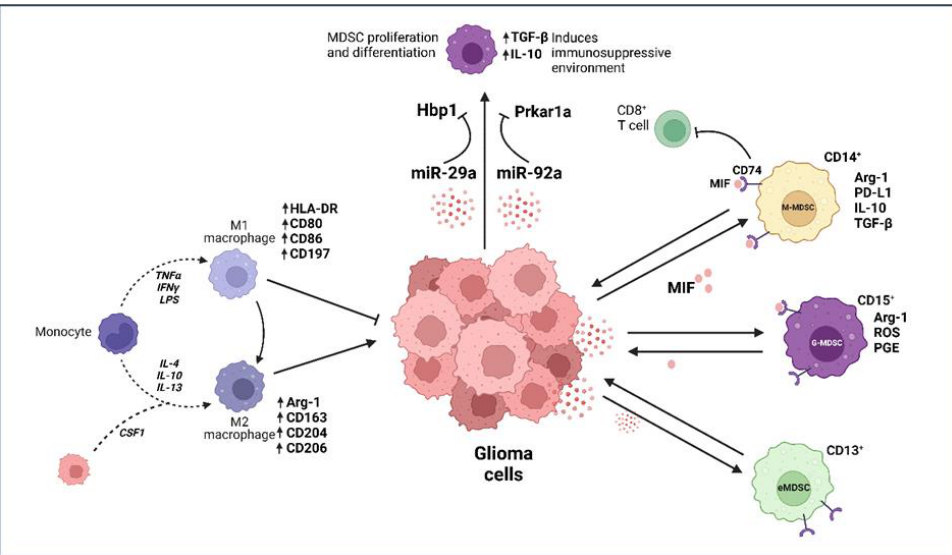
Figure 2. Myeloid immune cells induce immunosuppression within glioma microenvironment. IFNγ—interferon gamma, Hbp1—high-mobility group box transcription factor 1, Prkar1a—protein kinase cAMP-dependent type I regulatory subunit alpha, Arg-1—arginase-1, TGF-β—transforming growth factor β, CSF1—colony stimulating factor 1. Created with BioRender.com (accessed on 14 March 2023).